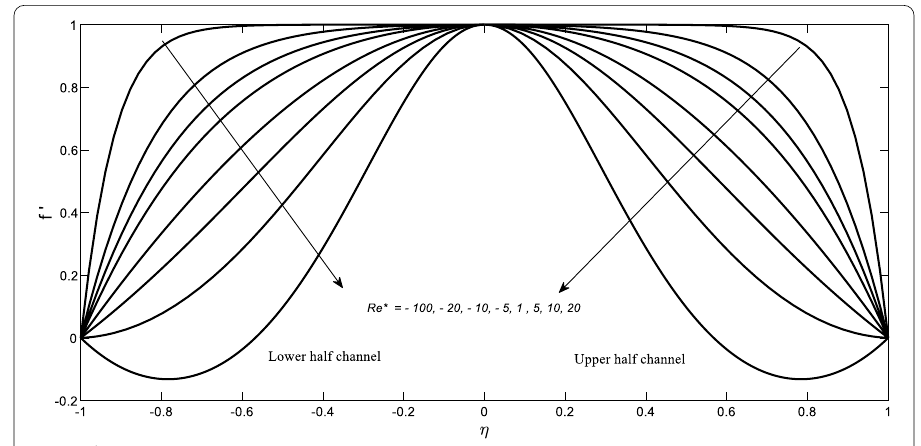
Fig. 2 f ′ is graphed against η for m